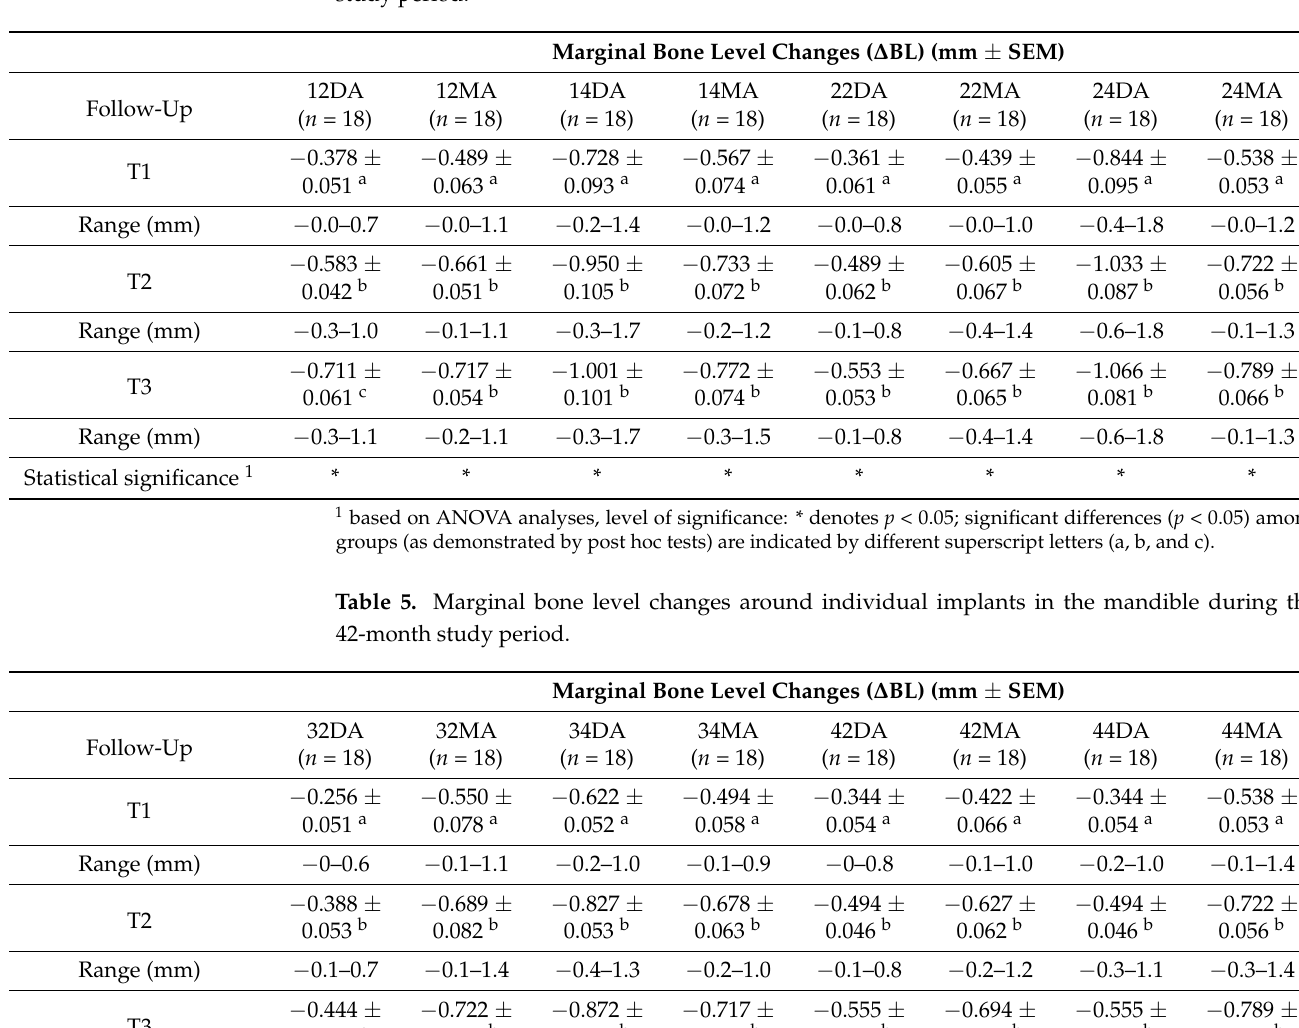
Table 4. Marginal bone-level changes around individual implants in the maxilla during the 42-month study period.